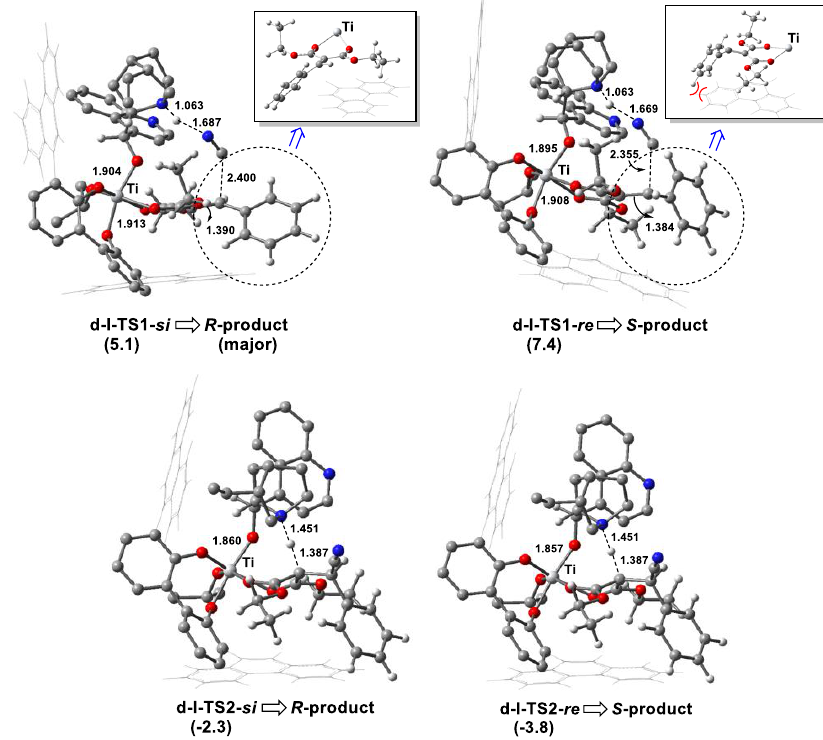
Figure 6. Optimized geometries of TSs in the C-C bond formation step (d-I-TS1- si and d-I-TS1- re ) and H-transfer step (d-I-TS2- si and d-I-TS2- re ) in the cyanation reaction of olefins catalyzed by Ti(IV)- complex along two competing pathways for R - and S -configuration products, respectively, associated with the relative Gibbs free energies (kcal mol −1 ). The intermolecular distance is in Angstroms ( Å ). The color definitions of atoms are red = oxygen, blue = nitrogen, gray = carbon and white = hydrogen.